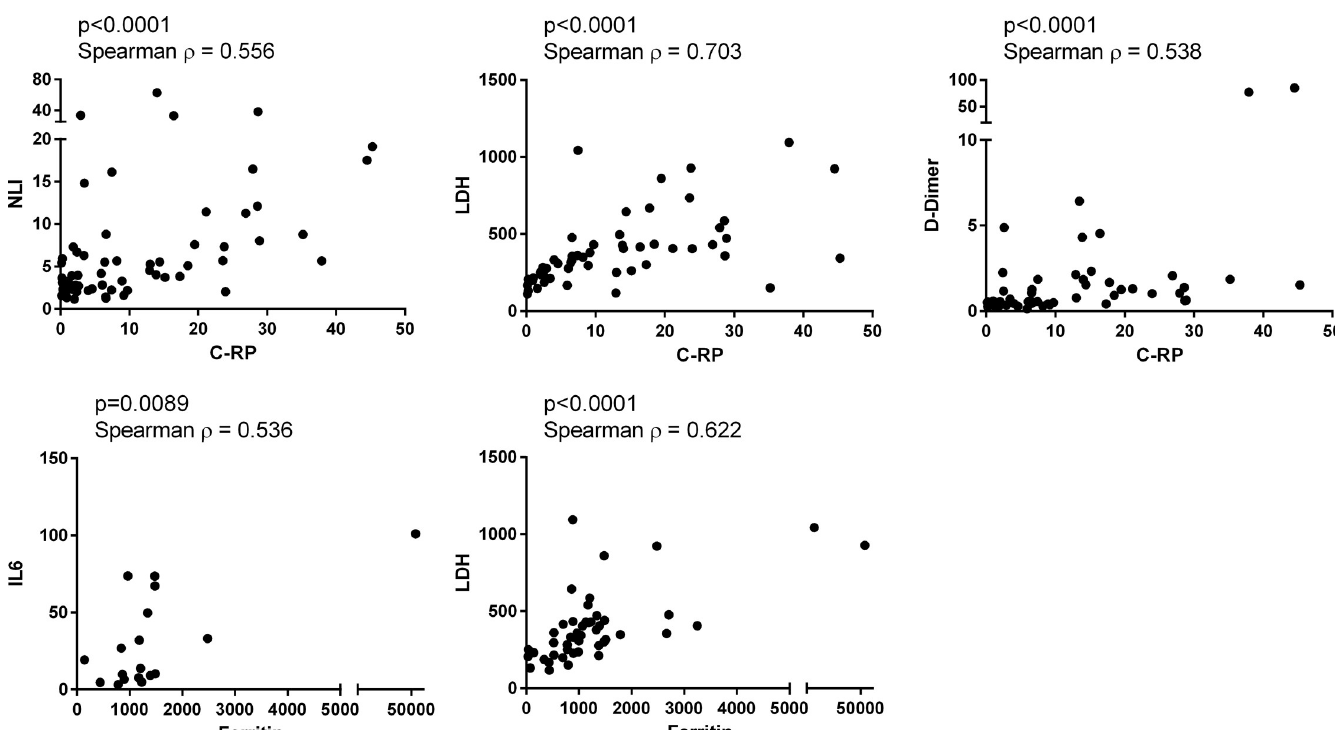
Fig 3. Correlation of laboratory parameters of disease severity. Data from laboratory tests was obtained from the clinical records of study participants. Shown are the graphical representation of the correlation analyses, as well as the parameters of significance and strength of the correlation for each data pair. C-RP (C-Reactive Protein), NLI (Neutrophil/Lymphocyte index), LDH (lactate dehydrogenase), D-Dimer (fibrin degradation product), IL6 (Interleukin 6).